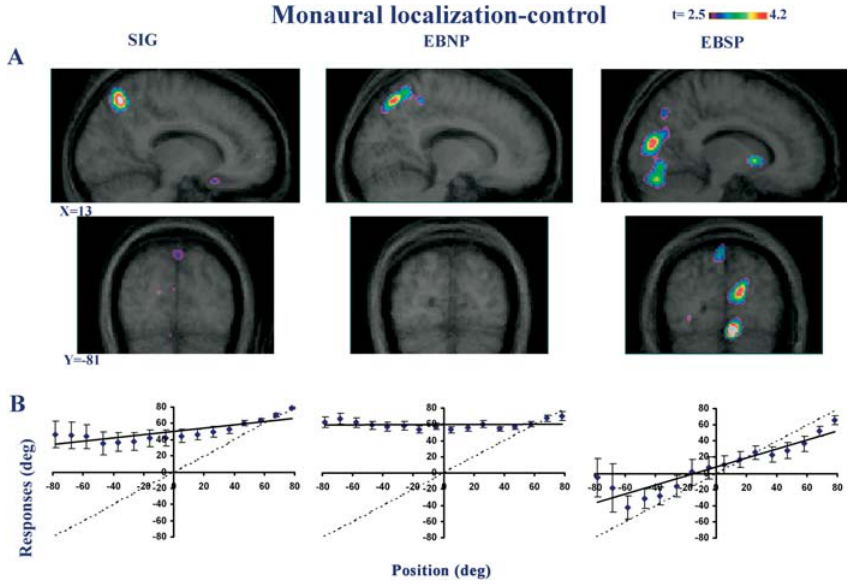
Figure 1. Monaural Sound Localization in PET Experiments Performed in the Three Groups of Subjects (A) CBF increases. Activations of the right striate and extrastriate cortices are observed in EBSP but not in the two other groups for the contrast of MSL minus its control task. Upper image series, sagittal slices; lower image series, coronal slices. X and Y coordinates refer to standardized stereotaxic space. (B) Behavioral data. Behavioral results in MSL task (with SE bars). The dashed lines represent the ideal performance, whereas the solid lines indicate the best linear fit to the observed localization performance. Negative angles on the abscissa correspond to the obstructed ear, while positive angles correspond to the unobstructed ear. Note the better performance of the EBSP group compared to the EBNP and SIG. DOI: 10.1371/journal.pbio.0030027.g001